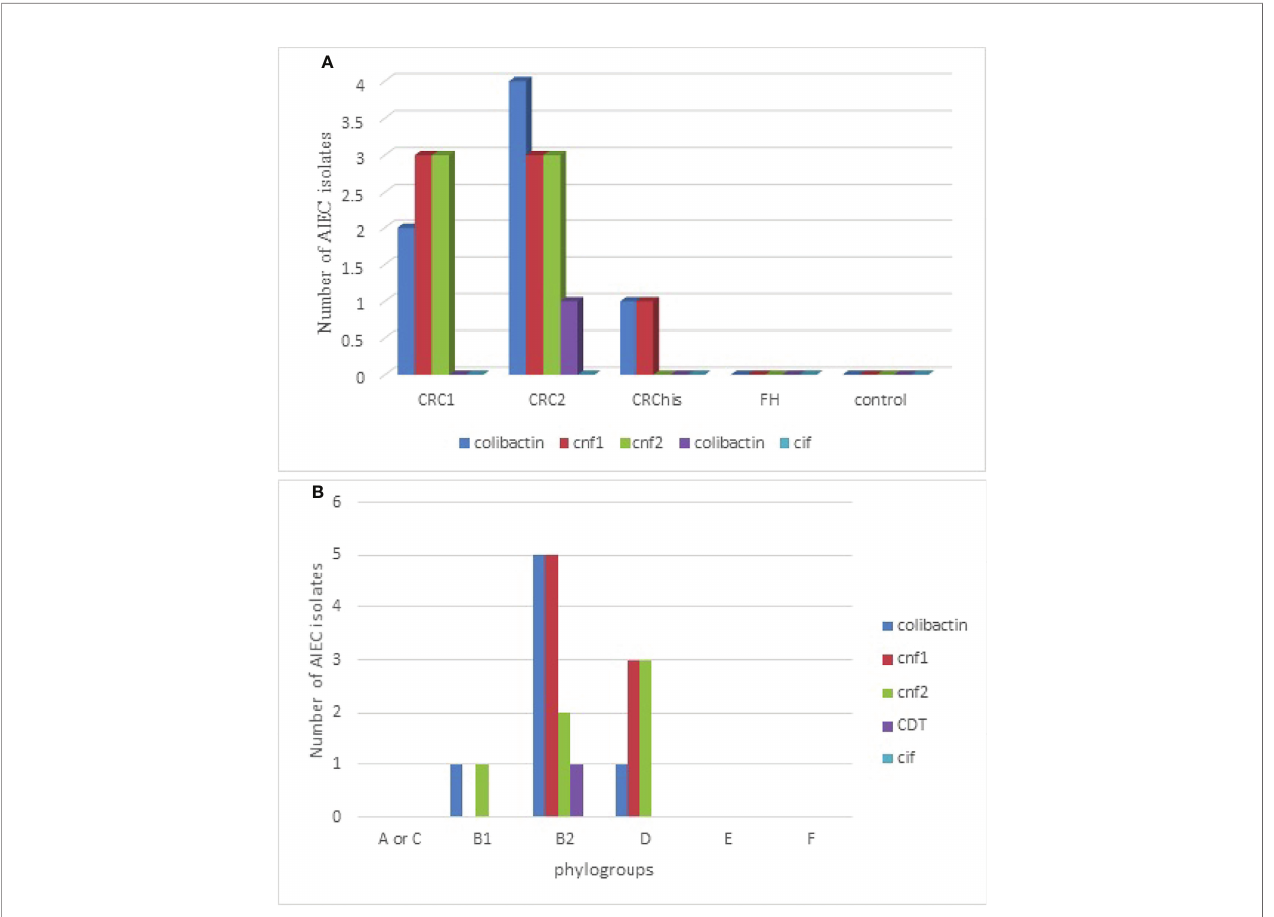
FIGURE 2 | Distribution of adherent – invasive Escherichia coli (AIEC) isolates producing various cyclomodulins according to the studied groups (A) and to phylogroups (B) . CRC1 , adenocarcinoma colorectal cancer in situ (Tis); CRC2 , colorectal cancer with tumor stage T1, T2, or T3; CRChis , with CRC history, but normal colonoscopy results, who have been referred for a 6-month follow-up; FH , normal results on colonoscopy, but with a family history of CRC based on the National Comprehensive Cancer